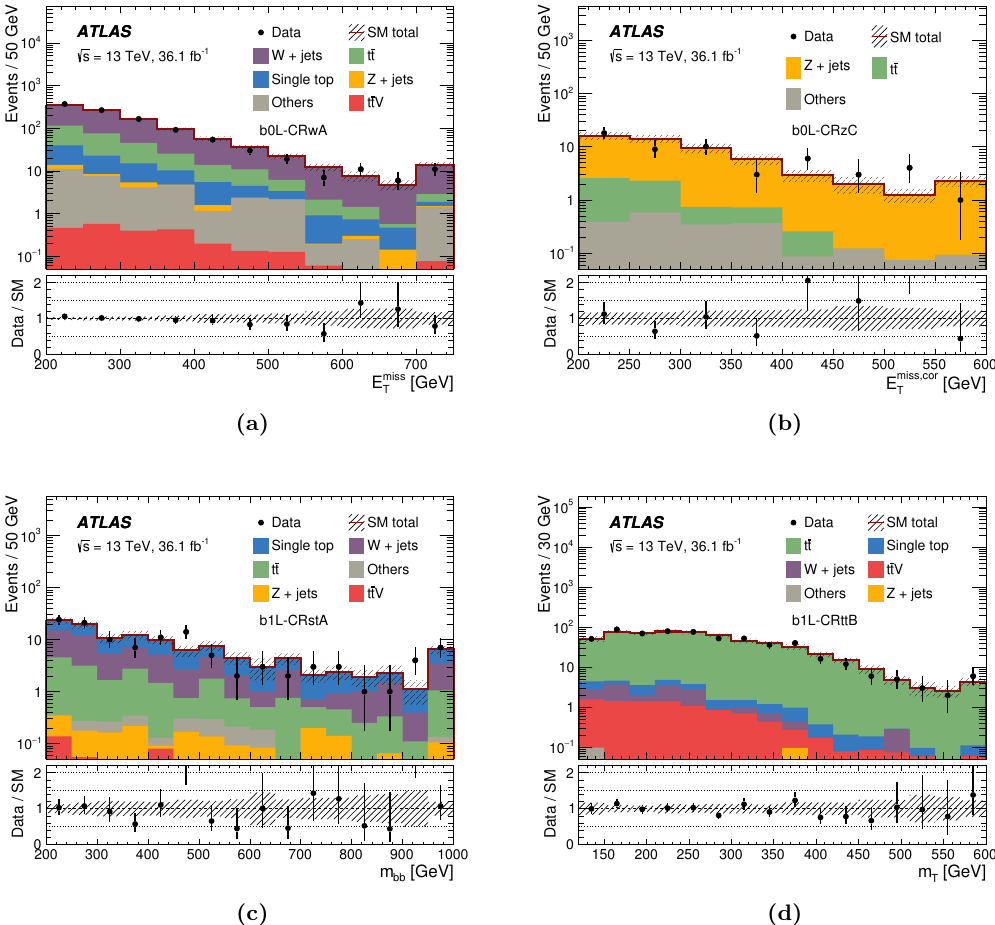
Figure 2. Example kinematic distributions in some of the control regions. (a) E miss (b) E miss ; cor in b0L-CRzC, (c) m bb in b1L-CRstA and (d) m T in b1L-CRttB. In all T